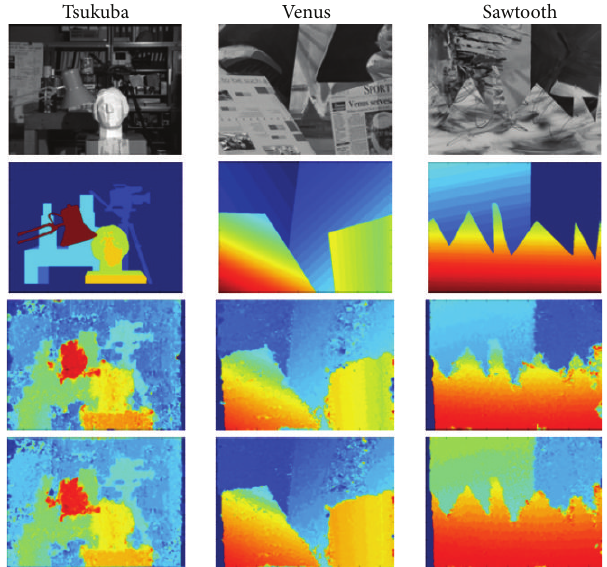
Figure 6: Comparison between horizontal disparity maps on Middlebury images [42] such that the first row corresponds to the left image of the pair; ground-truth disparity is shown in the second row and the computed disparity maps (disparity considered as a one-dimensionalshiftandamoregeneralizedarchitecturewithboth horizontal and vertical disparities) appear in the last two rows, respectively, such that disparity maps are coded from red (positive values of disparity) to blue (negative values).